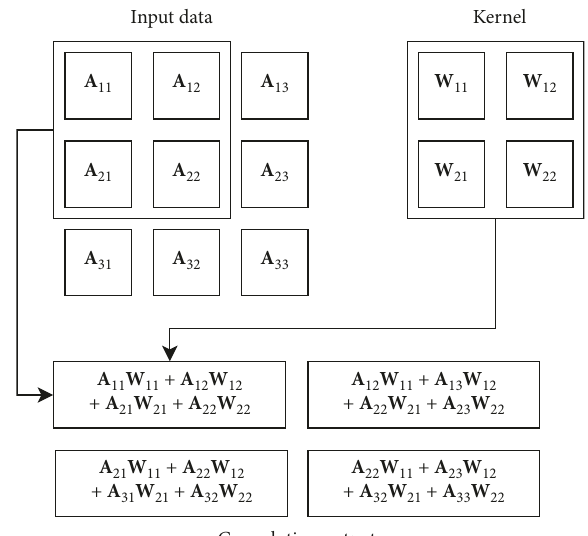
Figure 2: Convolution operation of a 3 × 3 input matrix and a 2 × 2 kernel.